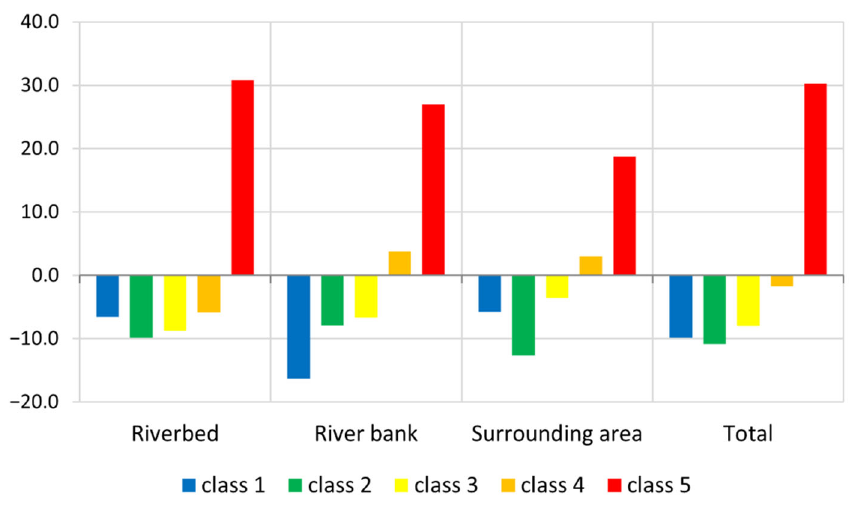
Figure 5. Difference (%) of the evaluation classes (1–5) of the Hase River between the Lower Saxonian Mountains (river type 6) and the Northwestern Lowlands (river type 15 and 15_g). The main parameters (MP1–MP6) are aggregated into the fields: river bed (MP1 = river development + MP2 = longitudinal section + MP4 = river bed structure), river bank (MP3 = cross-section + MP5 = bank structure), land (MP6 = watercourse environment/floodplain) and total evaluation.